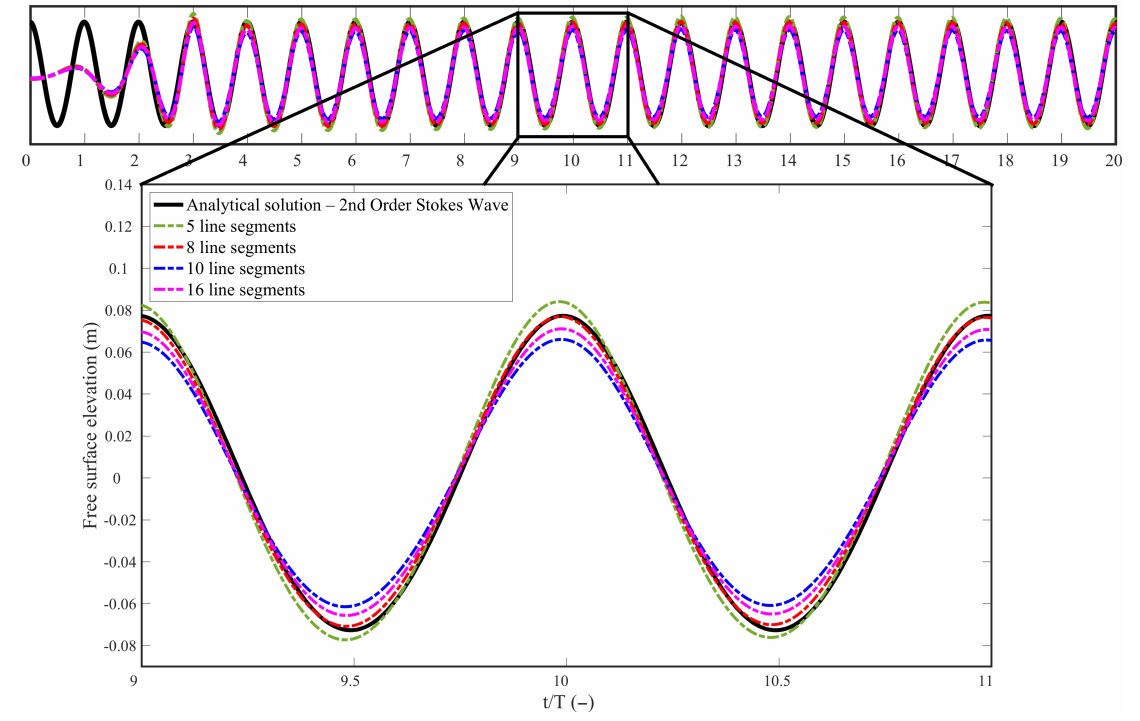
Figure 10. Comparison of the discretization at the wave generation region.